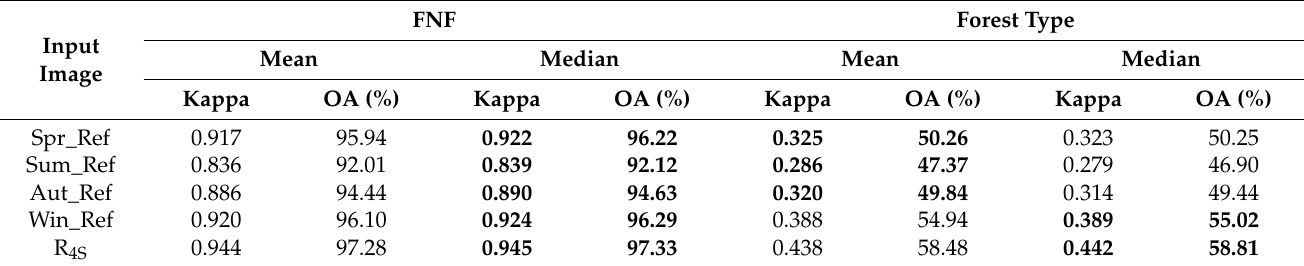
Table 8. The classification accuracy (OA and Kappa) comparison of composite images produced by two statistical operators (mean and median) of image composites tested in the proposed method.